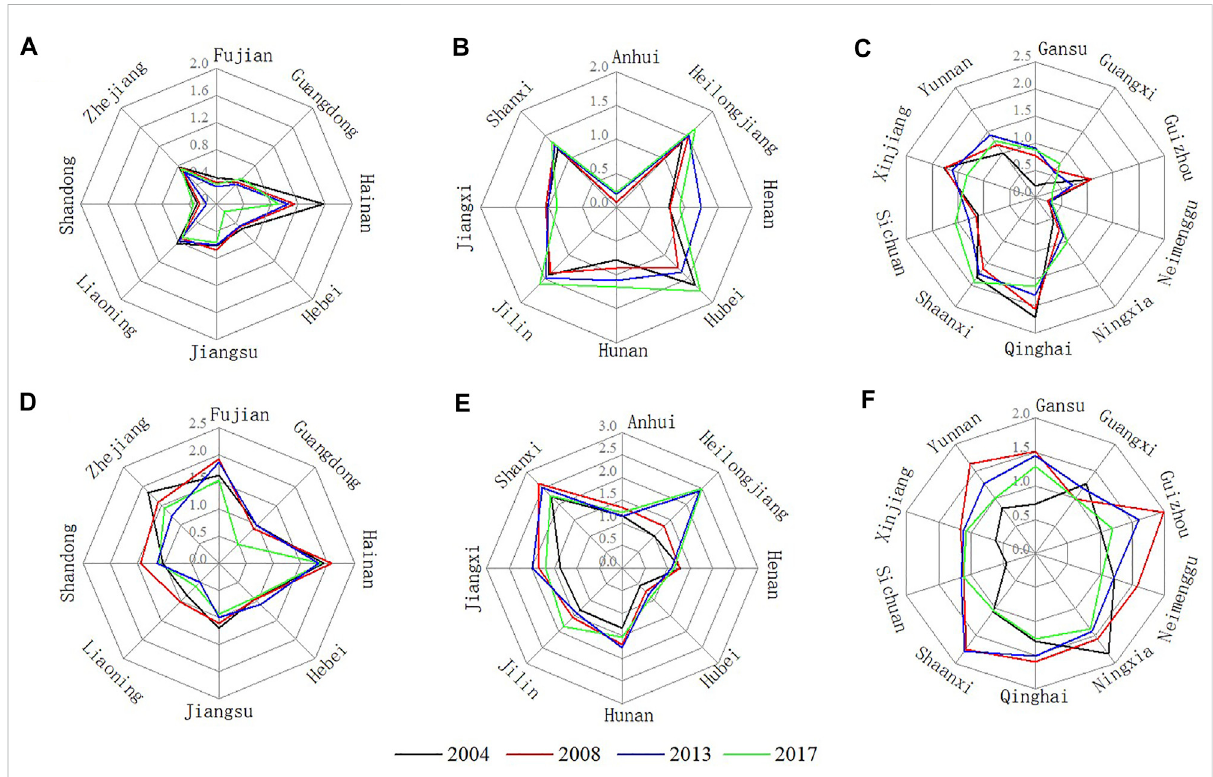
FIGURE 1 Temporal and spatial evolution trends of the spatial structure index of urbanization (A – C) and rural sustainable development ef fi ciency (D – F)